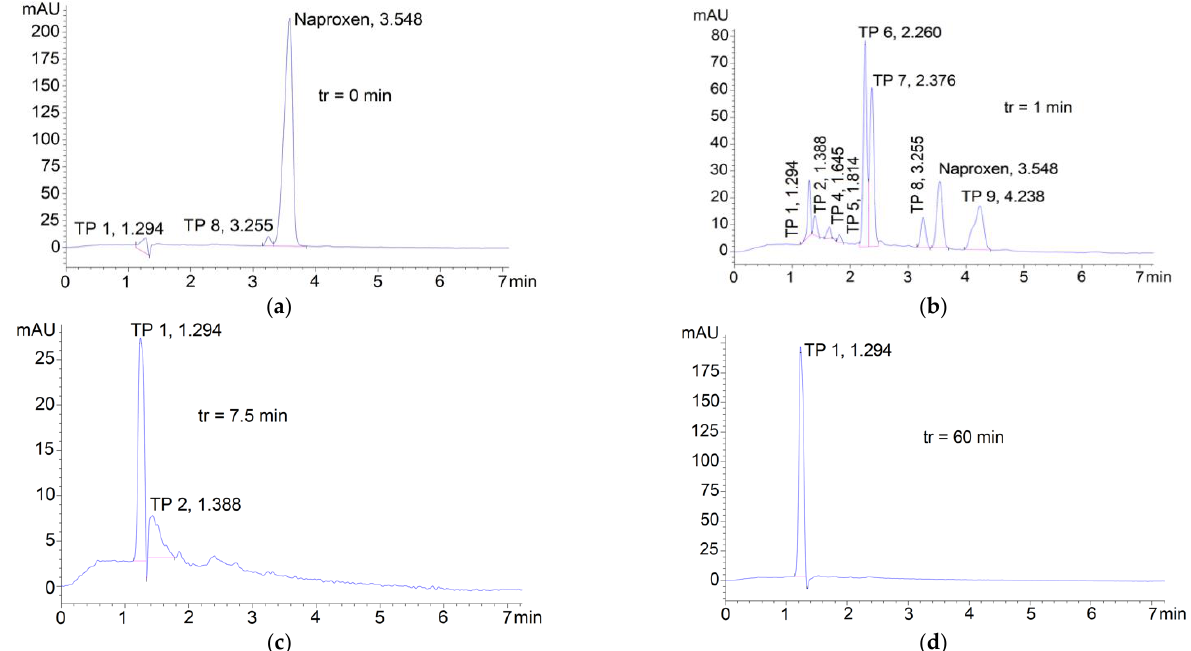
Figure 4. Electrochemical oxidation of naproxen and its transformation products (TP) at different reaction times with the highest current density (20.3 mA/cm 2 ) and lowest pH (3). ( a ) tr = 0 min; ( b ) tr = 1 min; ( c ) tr = 7.5 min; ( d ) tr = 60 min. TP refers to transformation products.